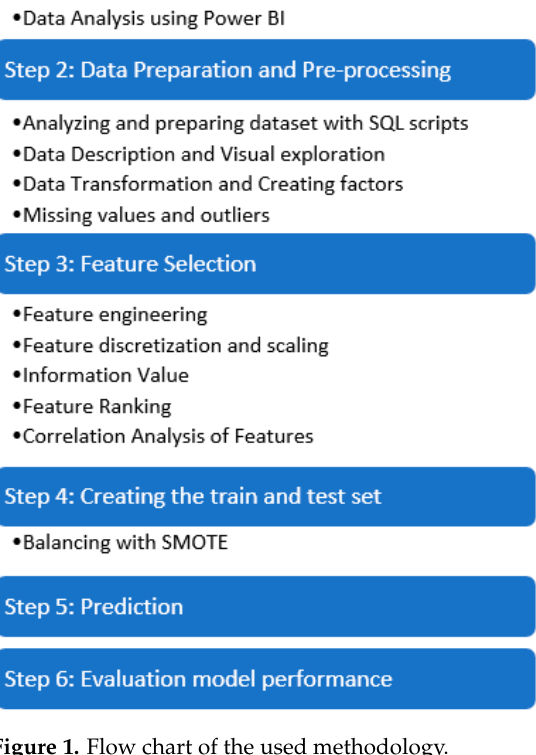
Figure 1. Flow chart of the used methodology.